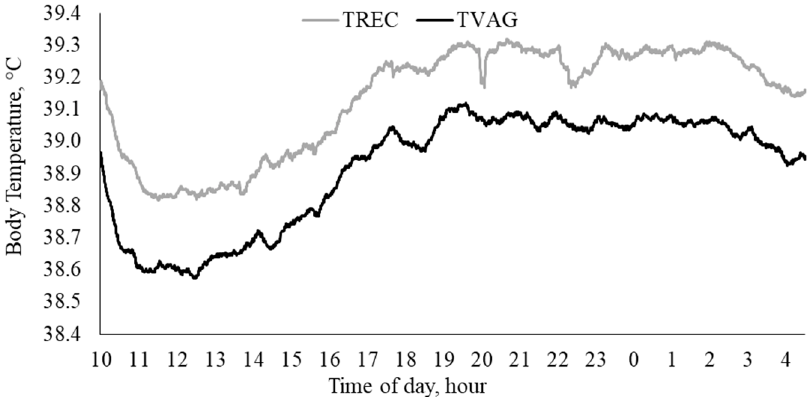
Figure 2. Trend in rectal temperature (T REC , °C) and vaginal temperature (T VAG , °C) over 18.5 h, in which data were recorded at twenty second intervals.